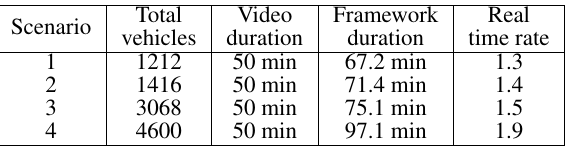
Table 6. Runtime result in test